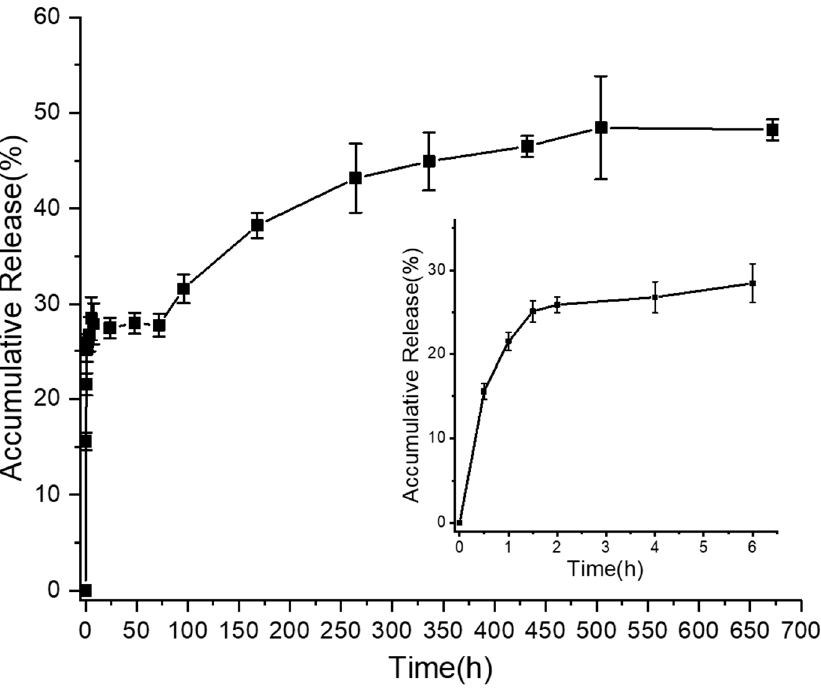
Figure 4. In vitro release profiles of PEP-1 from scaffold in PBS buffer. The inset shows the detailed release behaviors of mesh in the first 6 hour. Each data plot was measured from three samples.